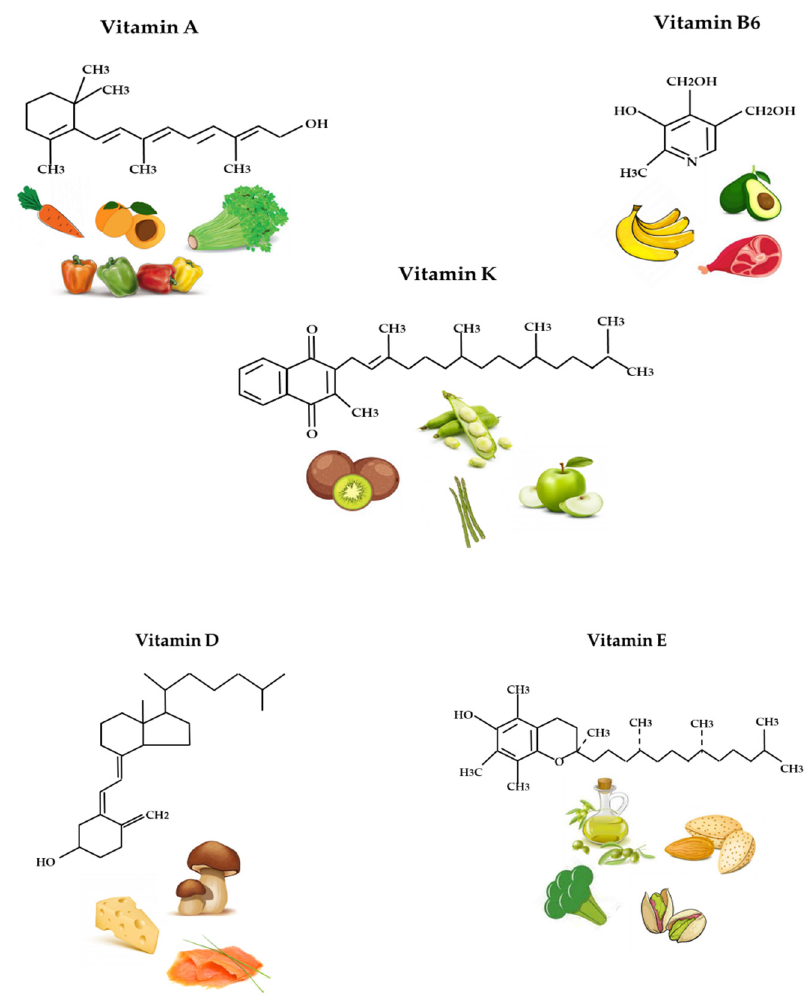
Figure 1. Chemical structures and food sources of vitamin A, B6, K, D, and E.